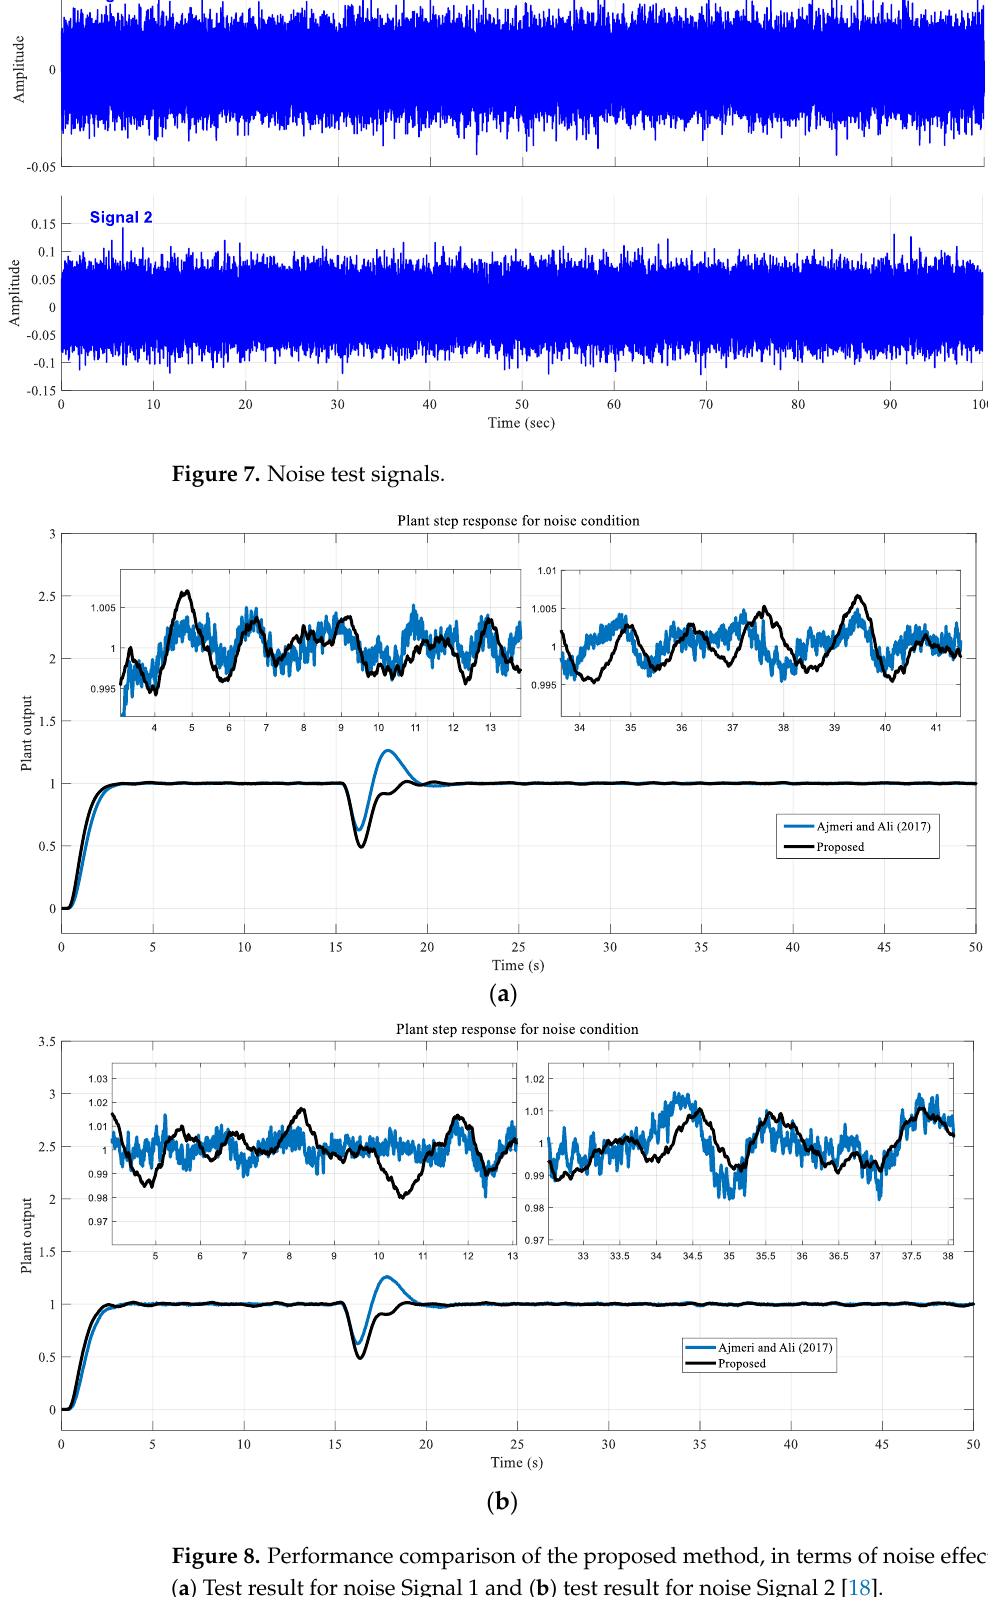
Figure 8. Performance comparison of the proposed method, in terms of noise effects, for Example 1. ( a ) Test result for noise Signal 1 and ( b ) test result for noise Signal 2 [18].